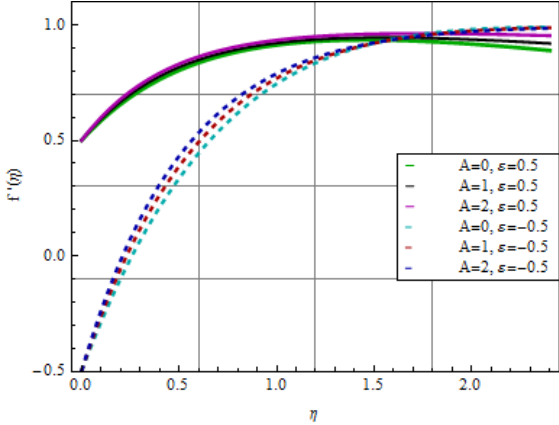
Fig. 9: The velocity distribution for alumina-sodium alginate nanofluid for different values of magnetic and velocity ratio pa- rameters with A = 0.5, U = 0.5, λ = 1, Pr = 6.2, ϕ = 0.2. w